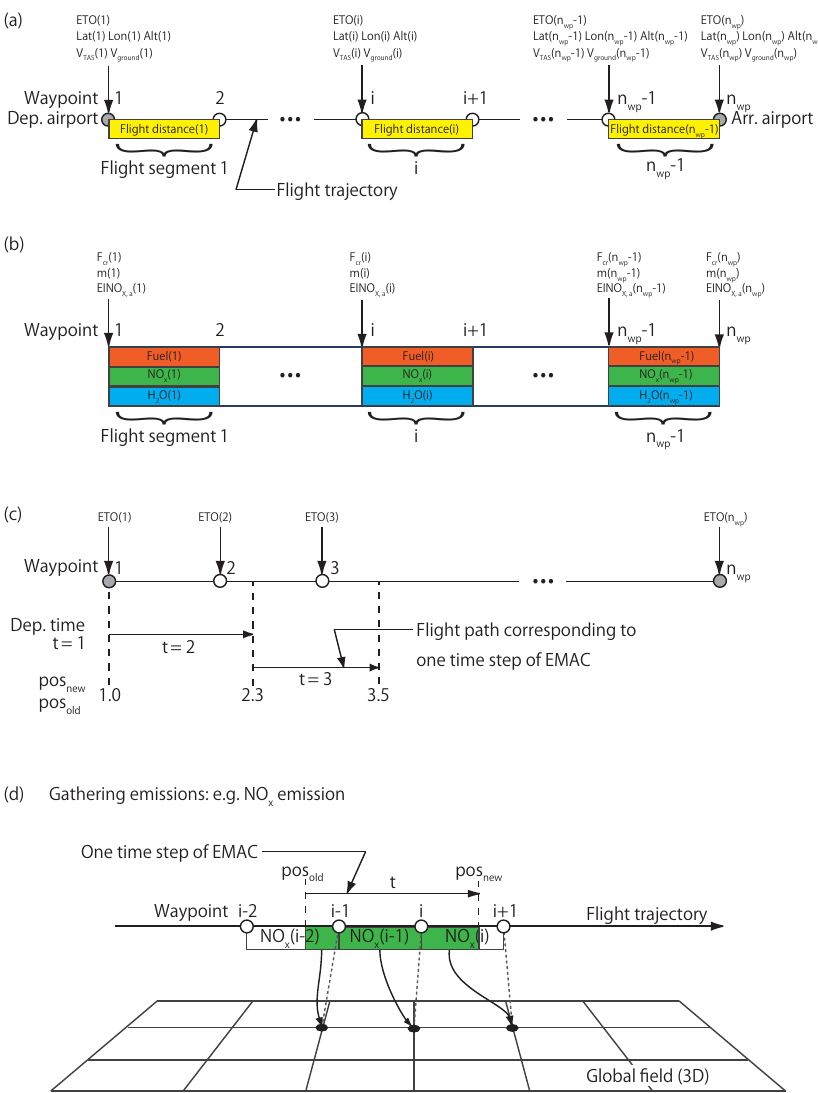
Figure 3. Illustration of the flying process of AirTraf (dashed box in Fig. 1, light blue). (a) Flight trajectory calculation. (b) Fuel/emissions calculation. (c) Aircraft position calculation. (d) Gathering global emissions; the fraction of NO x,i corresponding to the flight segment i is mapped onto the nearest grid point (closed circle) relative to the ( i + 1)th waypoint (open circle). ETO: estimated time over; F cr : fuel